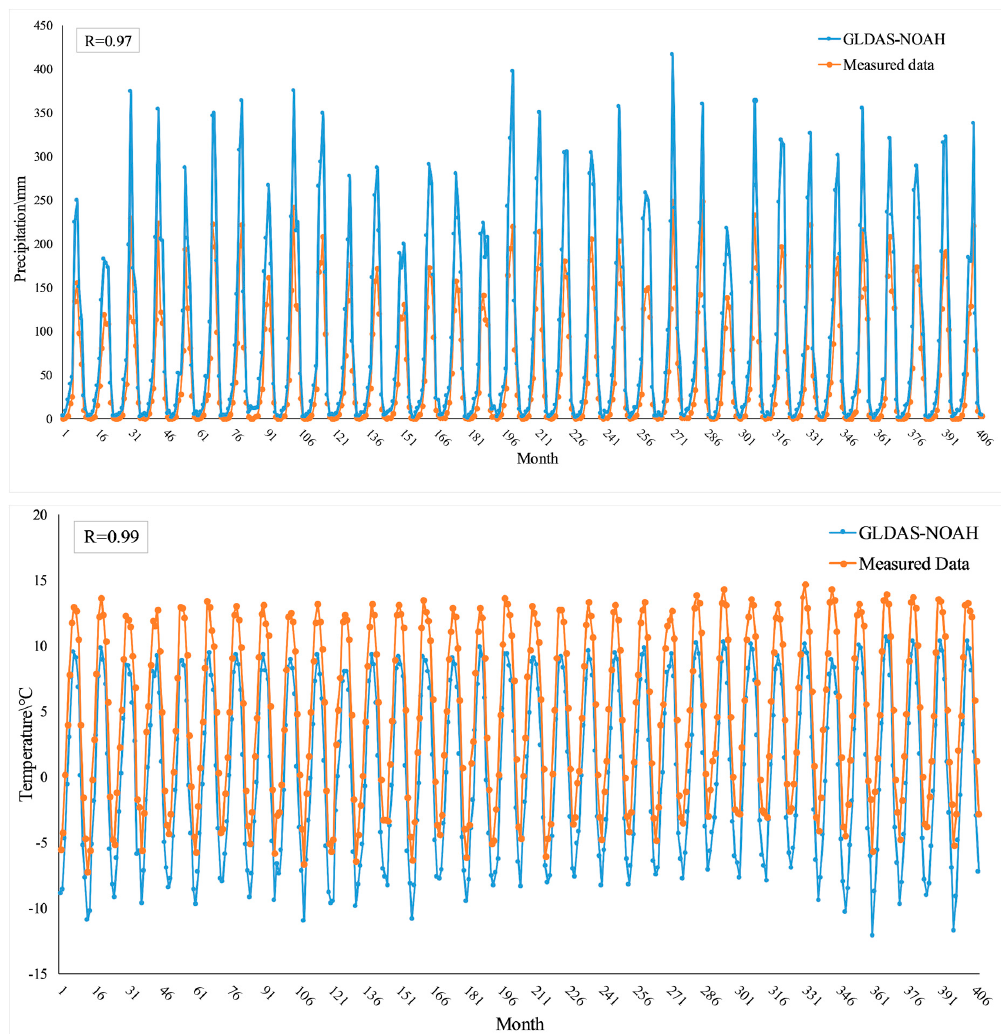
Figure 2. GLDAS-NOAH and measured monthly precipitation and temperature from 1982 to